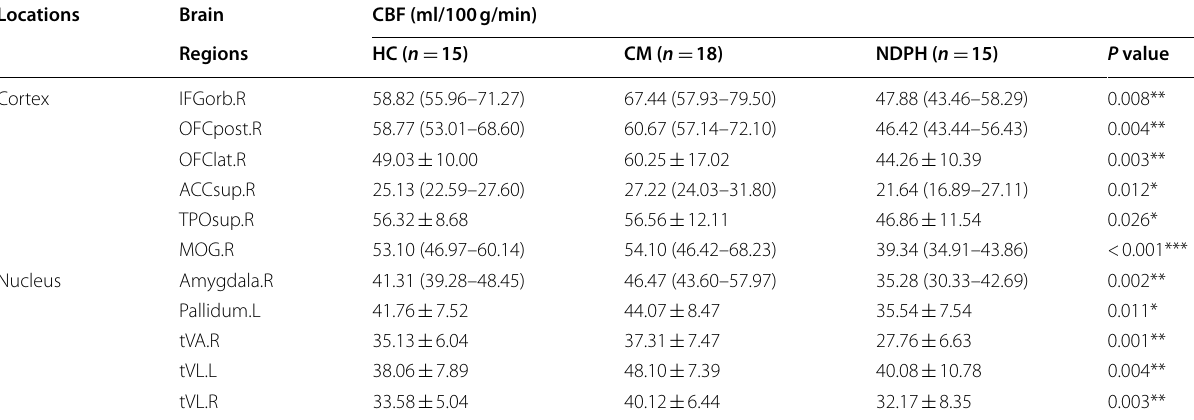
HC healthy control, NDPH new daily persistent headache, CM chronic migraine. IFGorb.R right inferior frontal gyrus pars orbitalis, OFCpost.R right posterior orbital gyrus, OFClat.R right lateral orbital gyrus, ACCsup.R right anterior cingulate cortex, supracallosal gyrus, TPOsup.R right superior temporal gyrus, temporal pole, MOG.R right middle occipital gyrus, Amygdala.R right amygdala, Pallidum.L left pallidum, tVA.R right thalamus, ventral anterior nucleus, tVL.L left thalamus, ventral lateral nucleus, tVL.R right thalamus, ventral lateral nucleus. * P <0.05, ** P <0.01,*** P